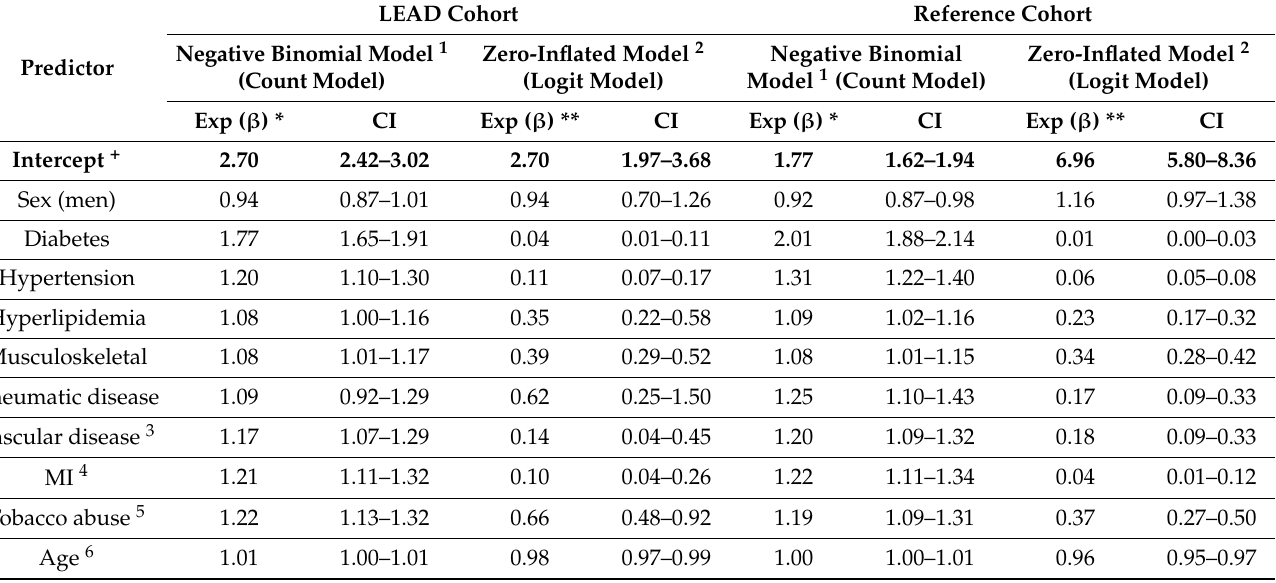
Table 2. ZINB regression coefficients for the number of healthcare contacts in LEAD and reference